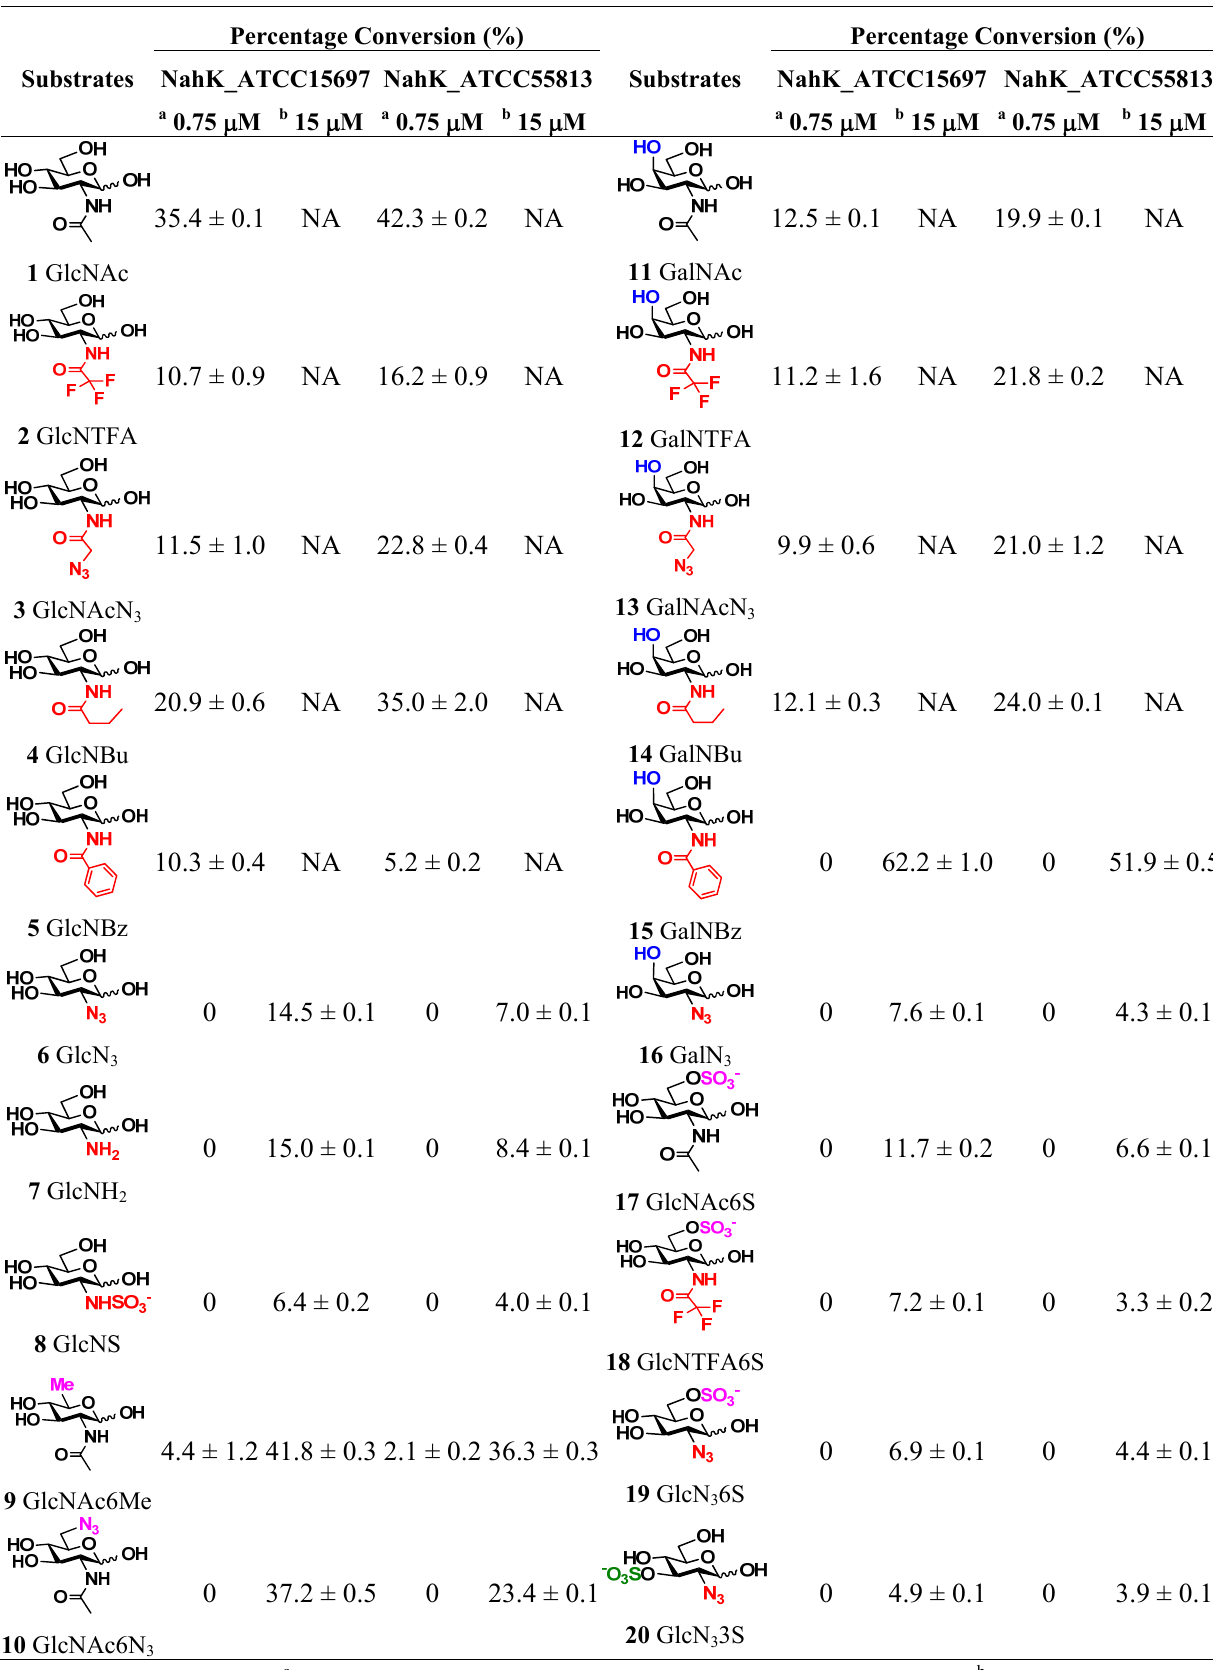
Table 2. Substrate specificity of NahKs using GlcNAc, GalNAc, and their derivatives. Percentage Conversion (%) Substrates